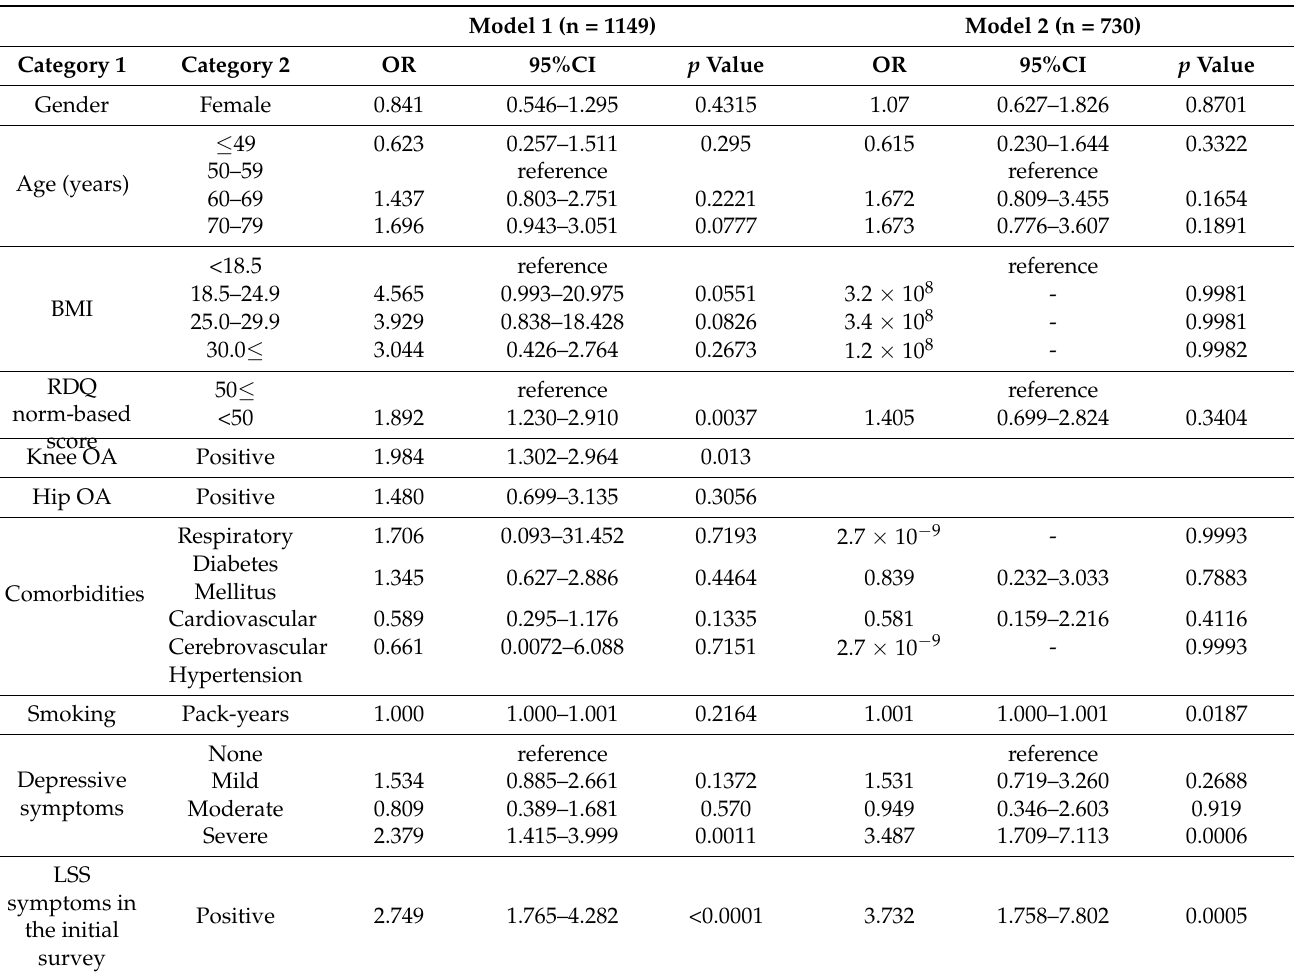
Table 5. The predictive factors of the occurrence of LSS symptoms during the 10-year follow-up